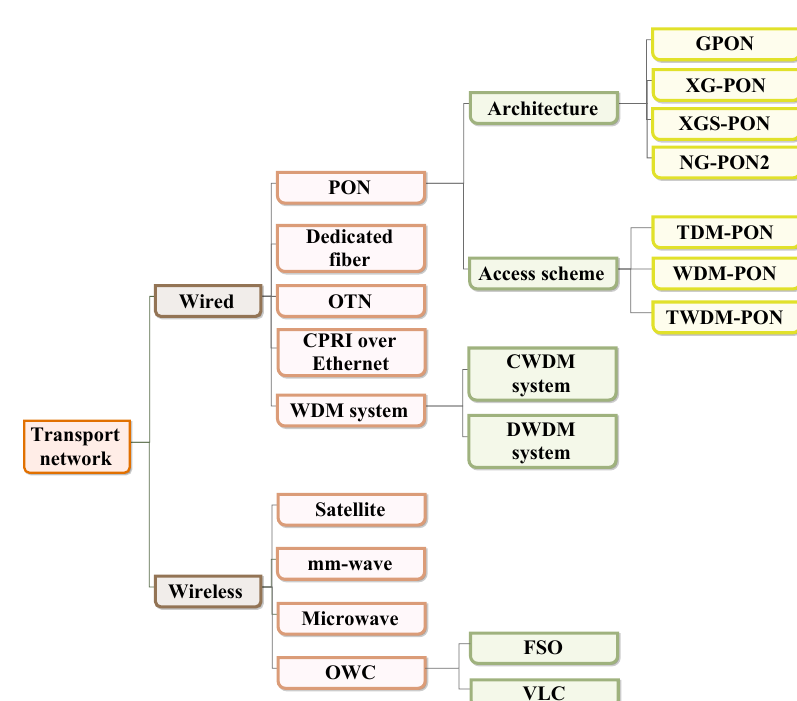
Figure 22. Transport network technology